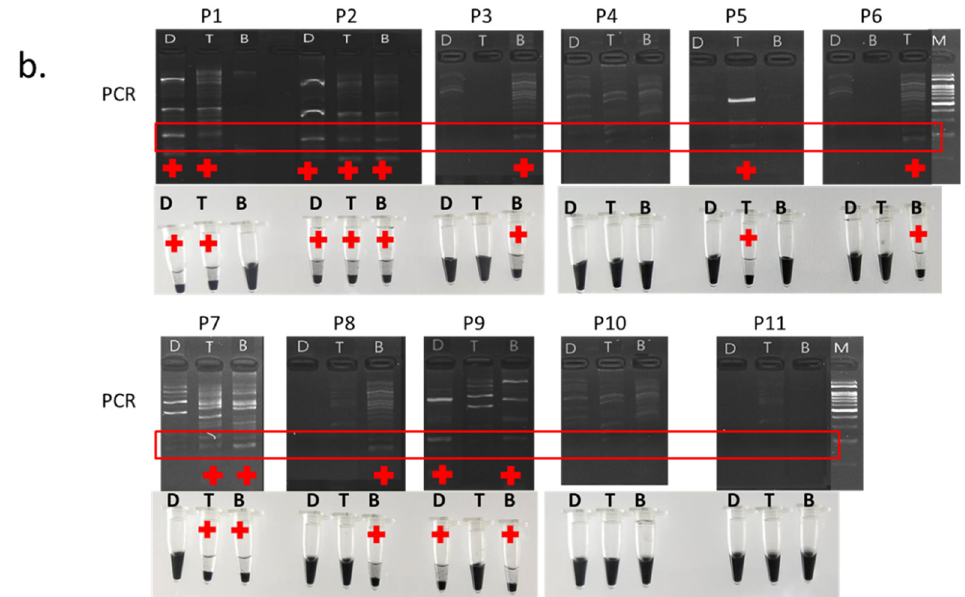
Figure 7. Validation of field applicability of samples LAMP assay and carbon flocculation assay by comparing the LAMP and carbon flocculation results using PCR: ( a ) samples from healthy plot (H1 and H2); and ( b ) samples from infected plot (P1, P2, P3, P4, P5, P6, P7, P8, P9, P10, P11). M = 100 bp DNA marker; D = leaves; T = stalk; and B = stem. ( + ) represents BDB detected in the sample and the red box indicates the size of amplified PCR band (280 bp). Each figure represents at least 3 experi- mental replicates.